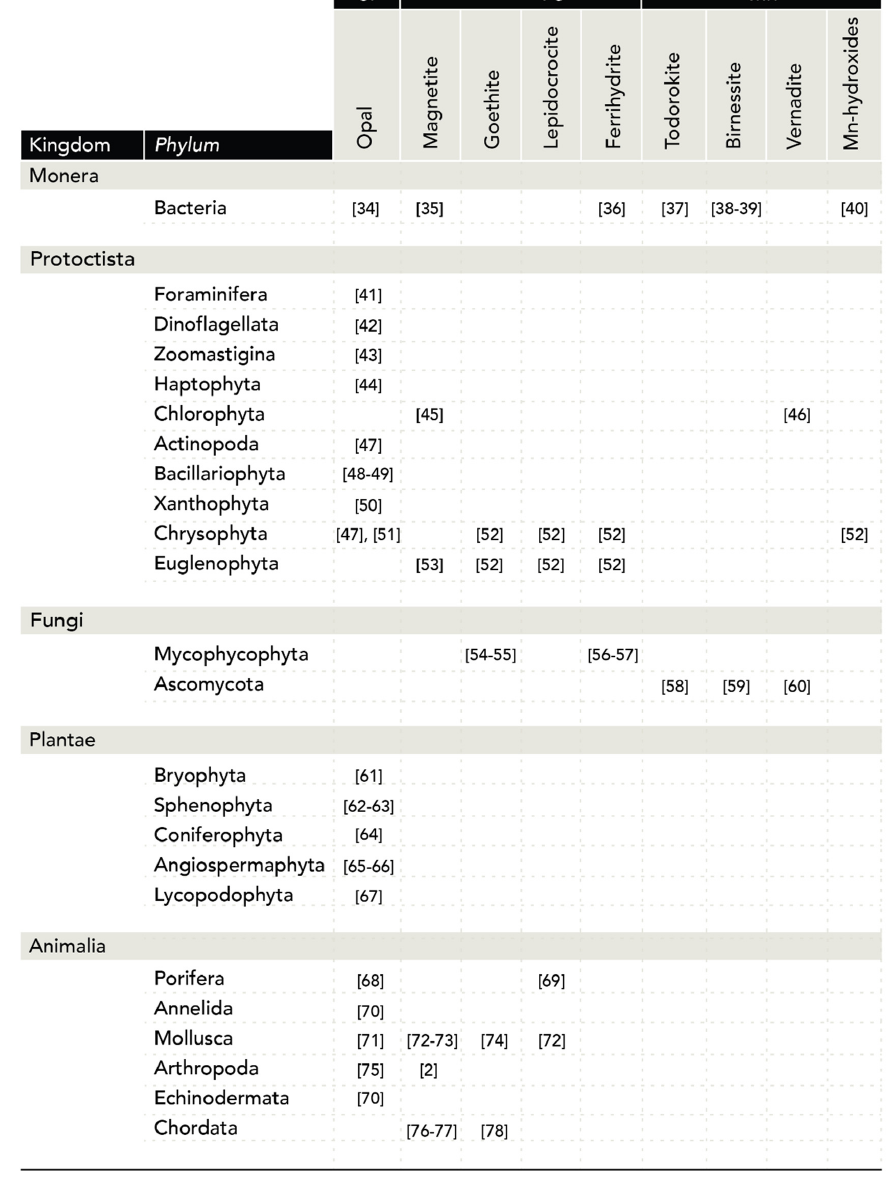
Figure 6. Location of biogenic metal oxides in the five different kingdoms. References are given in angular brackets. Compiled using data from references [2,34–78].